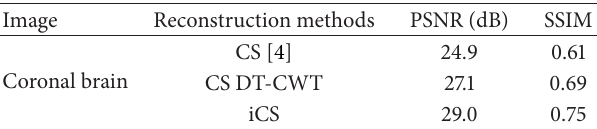
Table 2: PSNR and SSIM of coronal brain image with noisy data at 0.25 sampling rate. Image Reconstruction methods PSNR (dB) SSIM CS [4] 24.9 Coronal brain 29.0